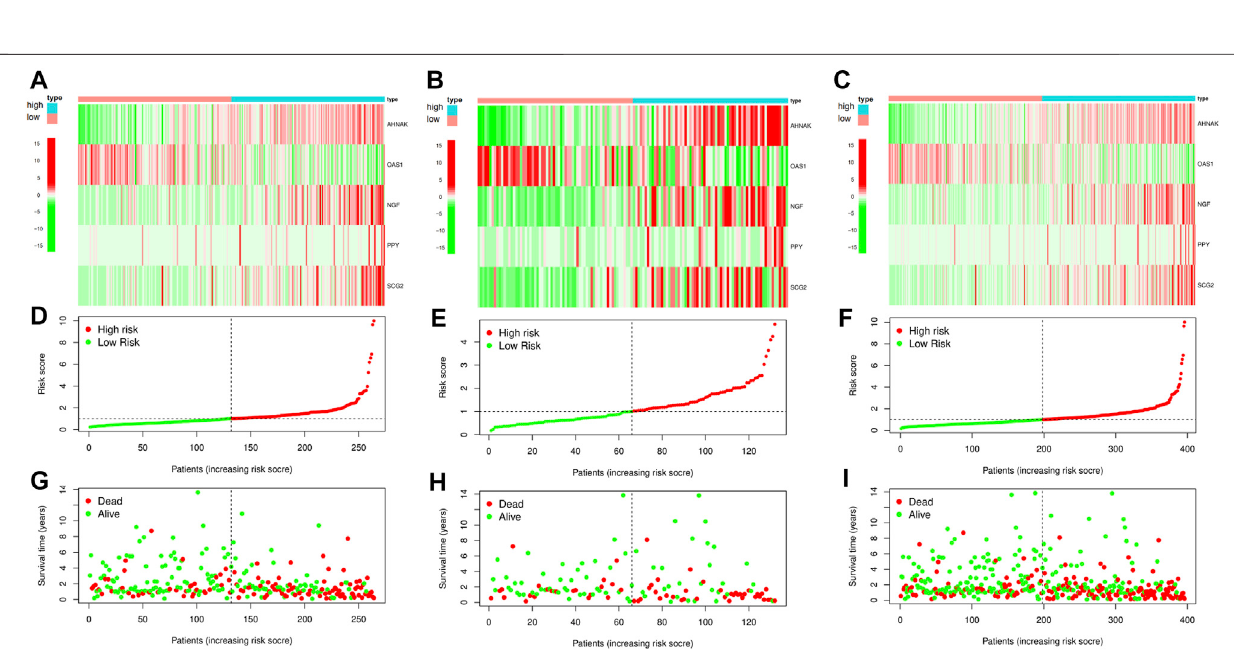
Frontiers in Genetics |